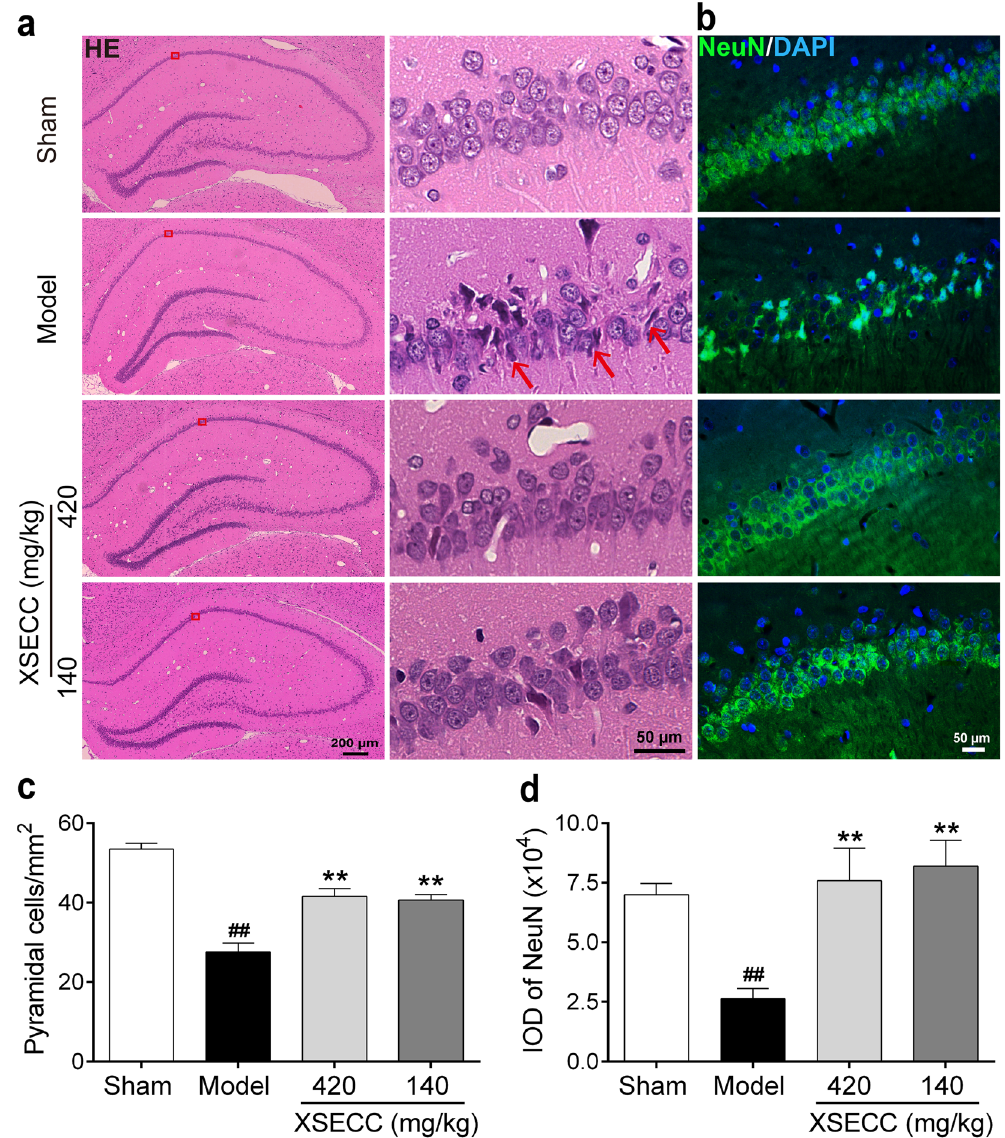
Figure 4. Effects of XSECC on neural injury in BCCAO rats. Four non-overlapping images (400 × magnification) within hippocampal CA1 of each animal were taken for the analysis of HE staining and NeuN immunofluorescence respectively. ( a ) Representative HE staining of the unilateral hippocampus (Scale bar: 200 μ m) and hippocampal CA1 area (Scale bar: 50 μ m) from sham, model and XSECC group rats. Red rectangle represented the region of interest located in the CA1 area of hippocampus. The neurons are shrinkaged and dark-stained in the model group rats (red arrows). ( b ) Immunofluorescence staining of NeuN in the hippocampus CA1 area (Scale bar: 50 μ m). ( c , d ) Analysis of pyramidal cells and NeuN expression in the hippocampal CA1 area respectively. ## P < 0.01 vs . sham group; ** P < 0.01 vs . model group (one-way ANOVA followed by LSD’s post hoc test, n = 6 per